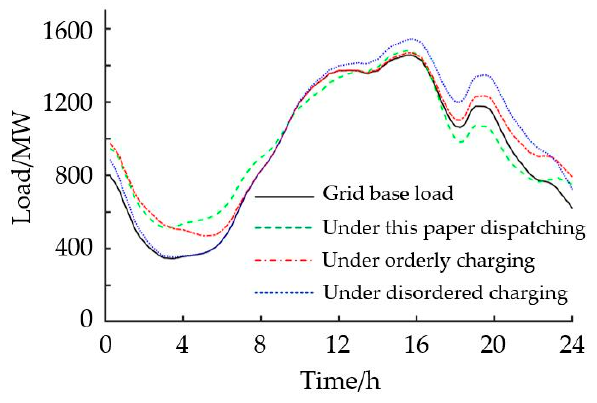
Figure 6. Total grid load.